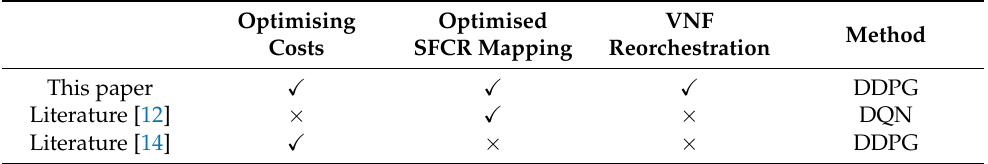
Table 1. Comparison of Optimization Objectives and